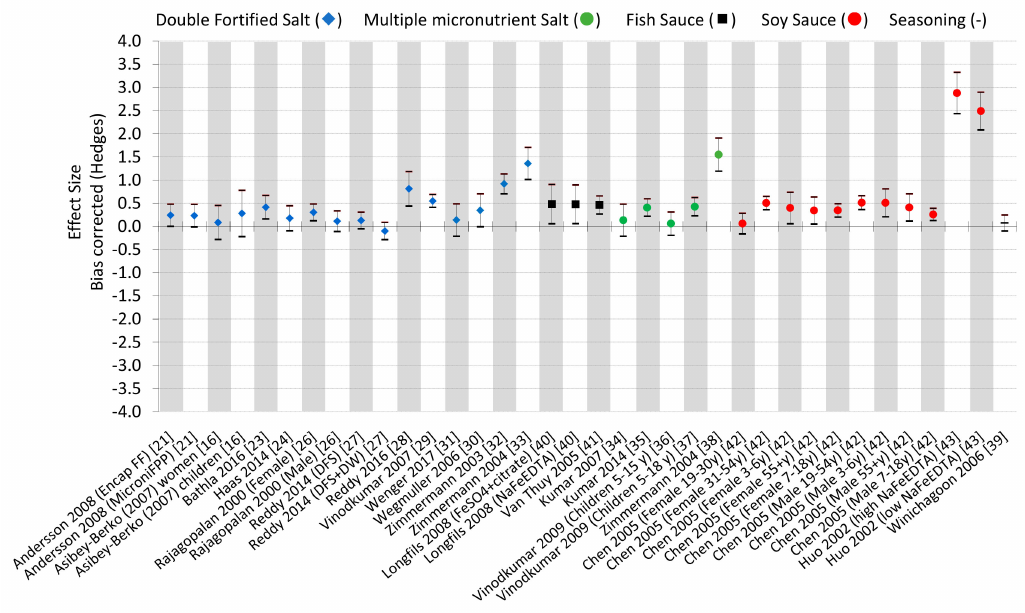
Figure 2. E ff ect sizes of studies included in this review. The e ff ect size was bias-corrected using